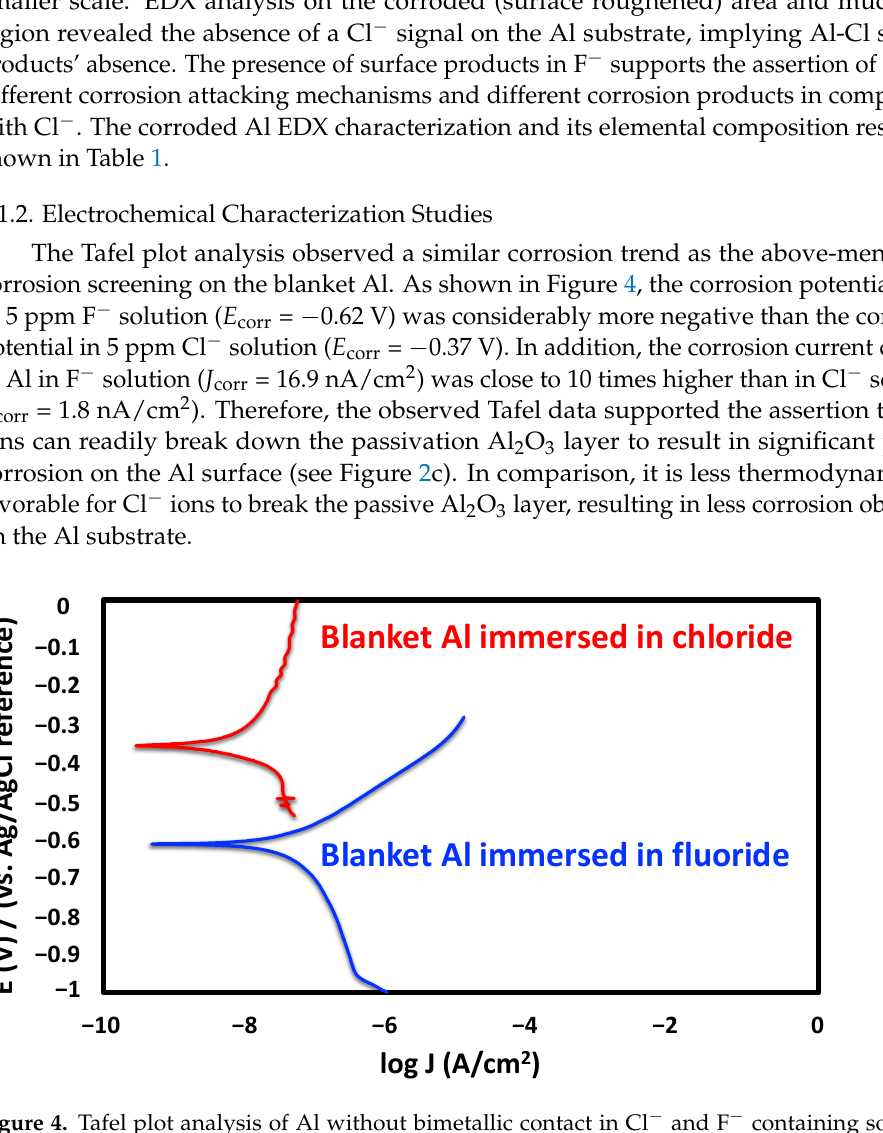
Table 1. EDS data for spots numbered in the SEM images in Figure 3.